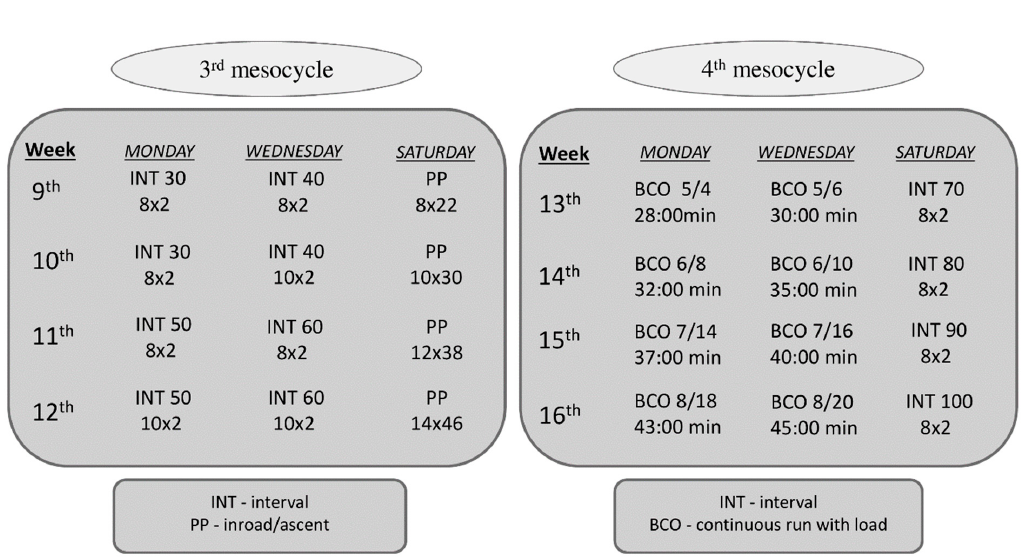
Figure 1. Macrocycle training protocol. OB 7 × 2—seven exercises × two circuits; TPS 50 × 4—length of football track (m) × number of repetitions, 60 × 4—length of “parachute run” (m) × number of lengths covered; INT 30 (8 × 2)—interval including 30 m of sprint (number of 330 m—long laps × 2 min per lap); PP 8 × 22—number of inroads × number of ascents; BCO 5 / 4—distance of run (km) × load (kg), below there is a time for completion of the BCO exercise.